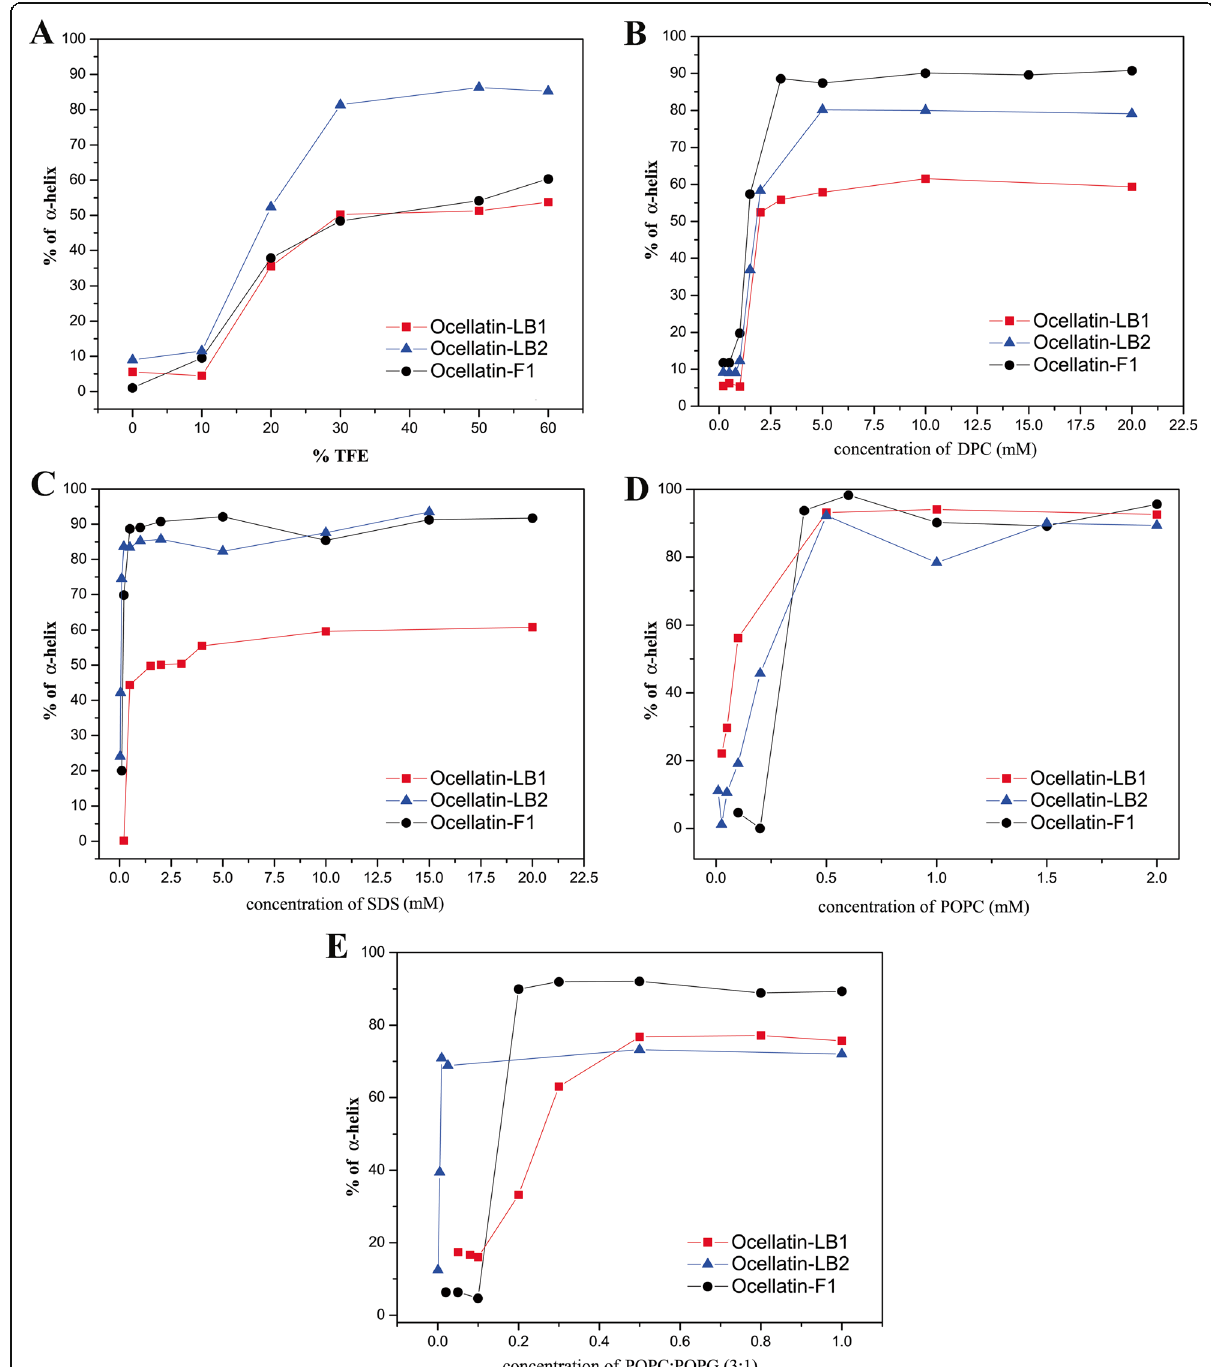
Fig. 8 Helical contents of ocellatin-LB1 ( red squares ), -LB2 ( blue triangles ) and -F1 ( black circles ) in the presence of ( a ) TFE:H 2 O solutions and as a function of ( b ) DPC, ( c ) SDS, ( d ) POPC and ( e ) POPC:POPG (3:1)